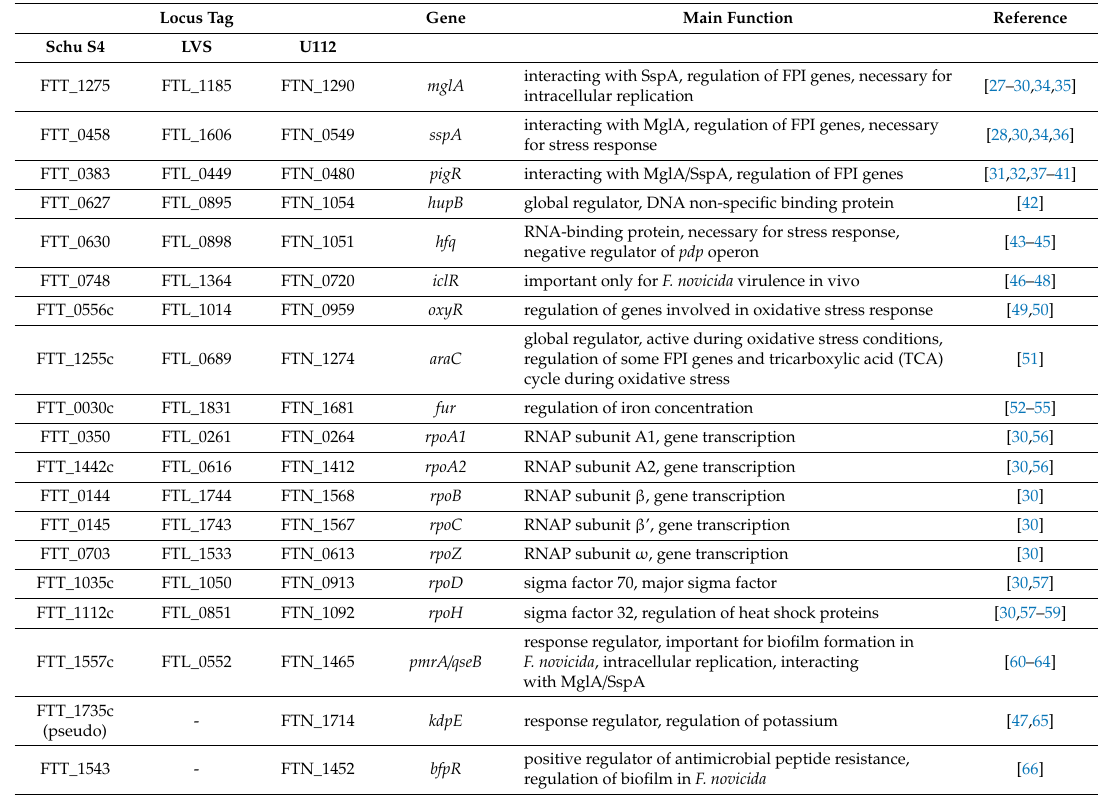
Table 1. Transcription regulators described in this